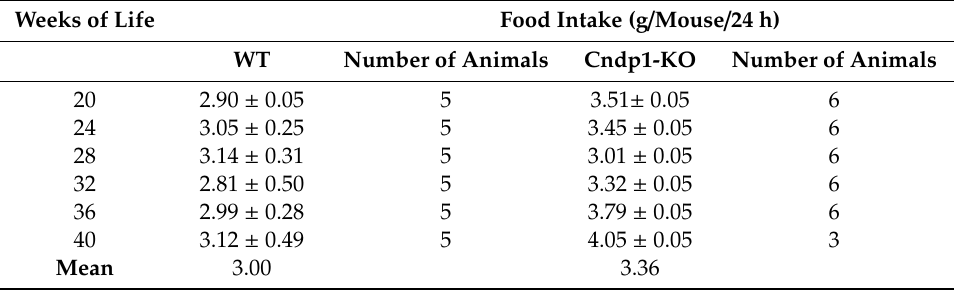
Table 5. Food intake of 11 and 55-week-old Cndp1 -KO and WT mice. Food intake was significantly higher in Cndp1-KO as compared to WT mice ( p =